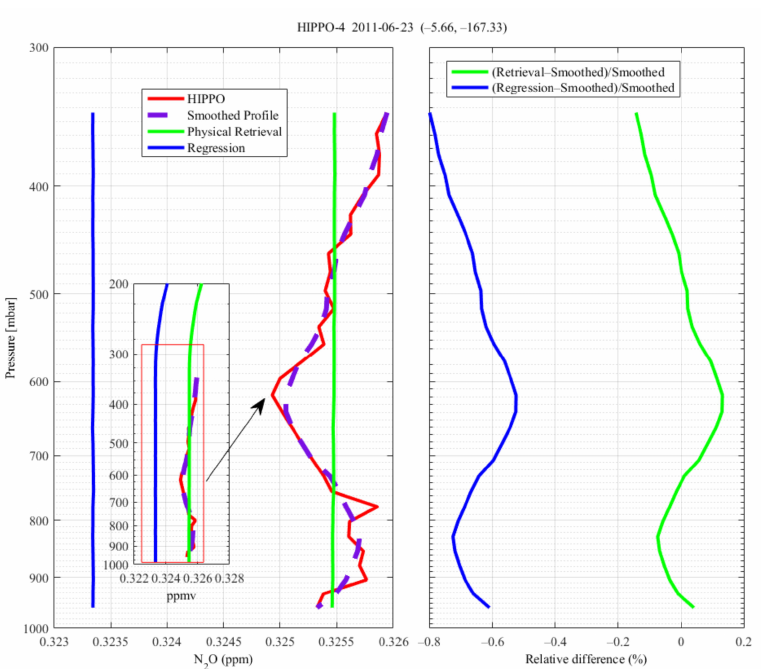
Figure 13. An example of the retrieval results for the tropical region (left) and the RD between the retrieval results and the HIPPO data